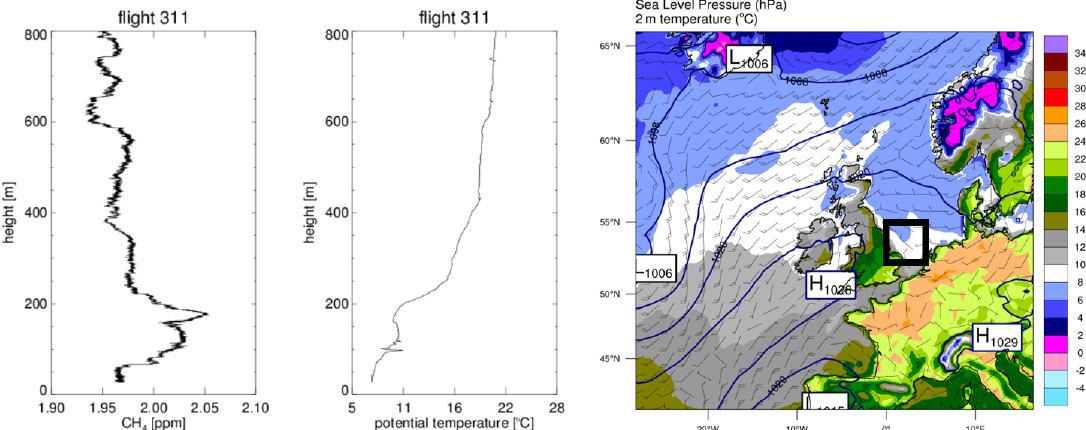
Figure 4. Example of CH 4 and potential-temperature profiles showing the large amount of structure arising from residual boundary layers. The increase of the potential temperature with height shows stable stratification of the boundary layer. The synoptic chart over the eastern North Atlantic and north-western Europe shows contoured sea level pressure (hPa), 2m temperature ( ◦ C, right-hand side colour scale) and wind for 20 April 2018 12:00UT and reveals relatively low wind speeds and poorly defined airflow over the southern North Sea sector, allowing for the build-up of residual boundary layers. Synoptic chart image produced by the UK National Centre for Atmospheric Science (NCAS) using Weather Research and Forecasting model WFR-ARW (Advanced Research WRF) version 3.7.1, with a 20km grid spacing and 51 vertical levels initialised using the NOAA Global Forecast System. NCAS (National Centre for Atmospheric Science) Weather Research Catalogue (https://sci.ncas.ac.uk/nwr/pages/home, last access: 6 November 2020). The black rectangle approximates the survey region.